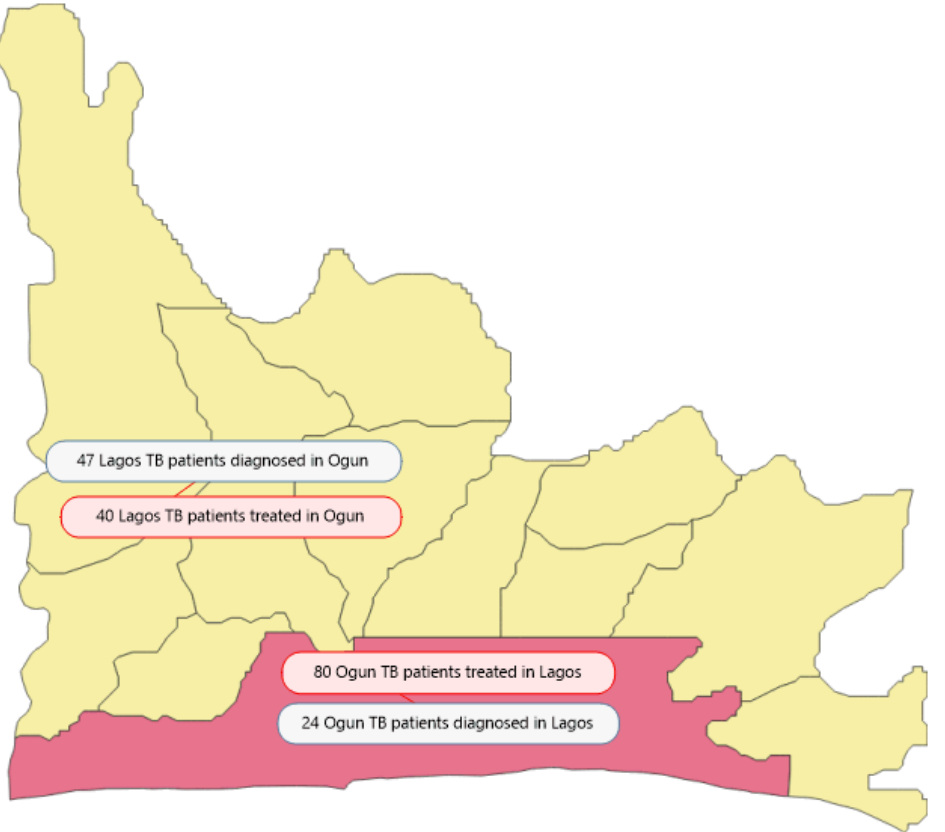
Figure 7. Schematic of cross-border TB diagnosis and treatment. TB: